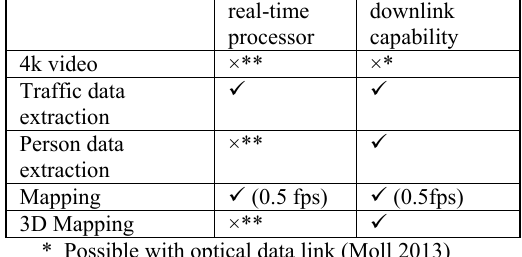
Table 4. Status of installed processors and downlink